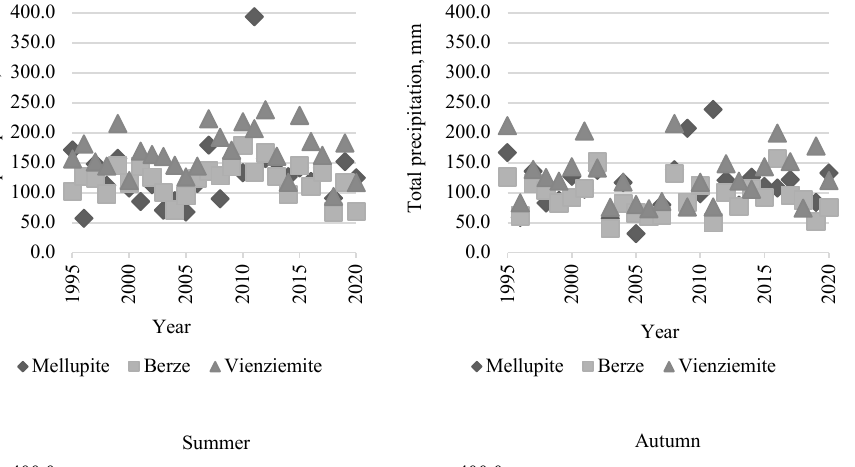
season and the rate of snowmelt. Humidity and high air temperatures are the main factors